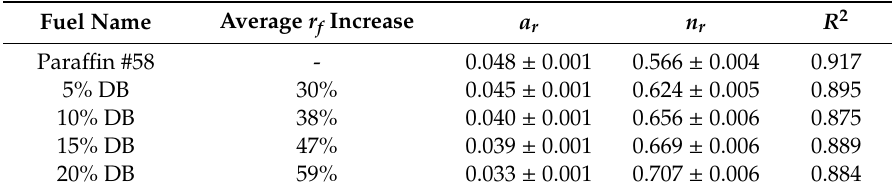
Table 5. r f increase and fitting results of r f vs. G ox for double-base (DB) particles / para ffi n composite fuels with 0, 5%, 10%, 15%, 20% DB showing increasing regression rate and slope n r for increasing DB load [27]. Copyright Begell House (2017). Reproduced with